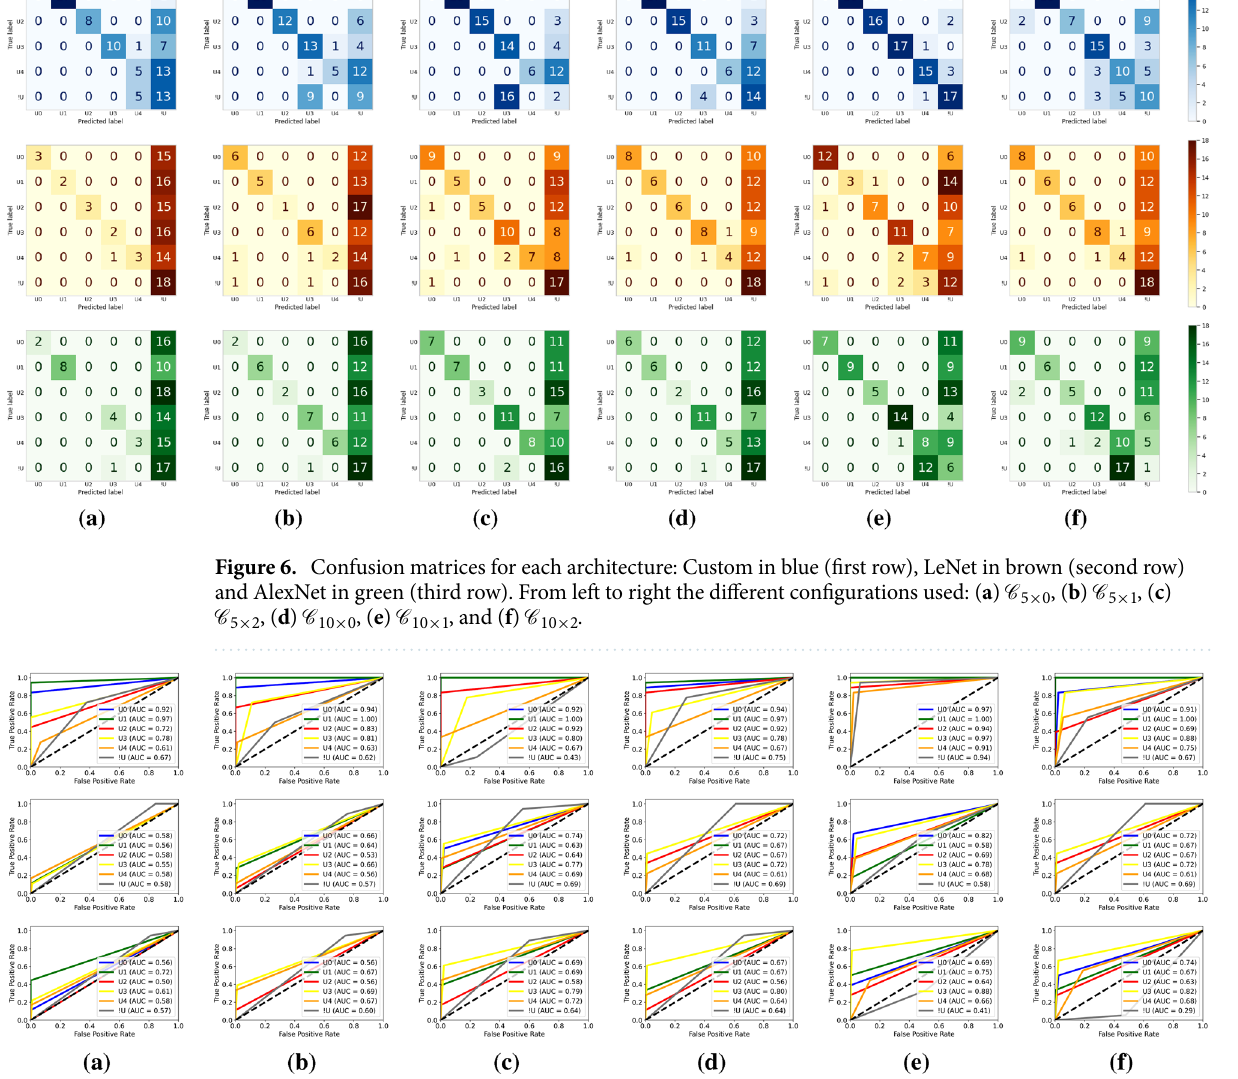
Figure 7. Receiver Operating Characteristic (ROC) curves and Area Under the Curve (AUC) for custom (first row), LeNet (second row) and AlexNet (third row). From left to right the different configurations used: ( a ) C 5 × 0